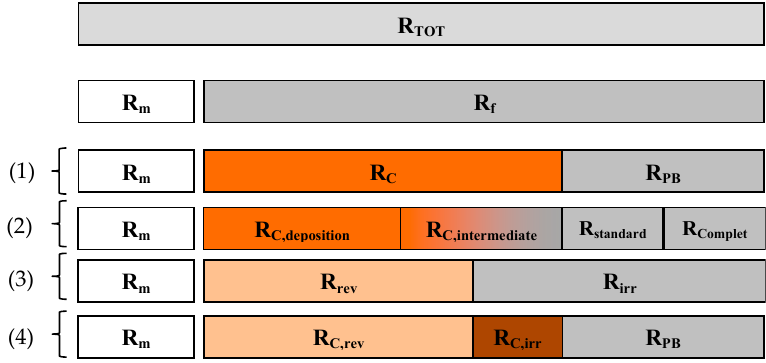
Figure 6. Resistances decomposition in different resistance-in-series (RIS) models applied; where: (1) is Chu and Li [83]; (2) is Le-Clech et al. [59]; (3) is Di Bella et al. [55]; (4) is Di Bella et al. [57].